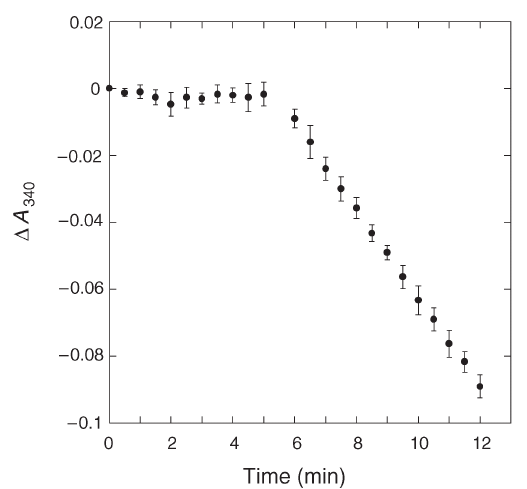
Figure 3. Requirement for an acceptor substrate for enzyme turnover. Each valuerepresentsthemeanoftriplicateassays.Erythrose-4-phos- phate was added at the 5 min mark. See Materials and methods for de-